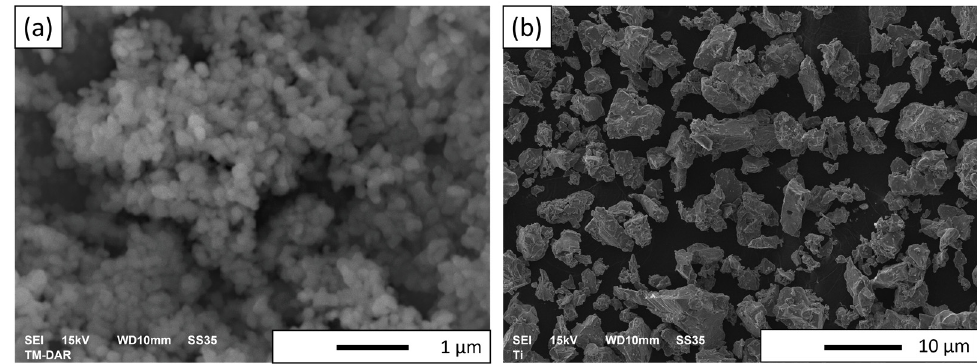
Figure 2. Sample SEM pictures of Al 2 O 3 ( a ) and Ti ( b ) powder.